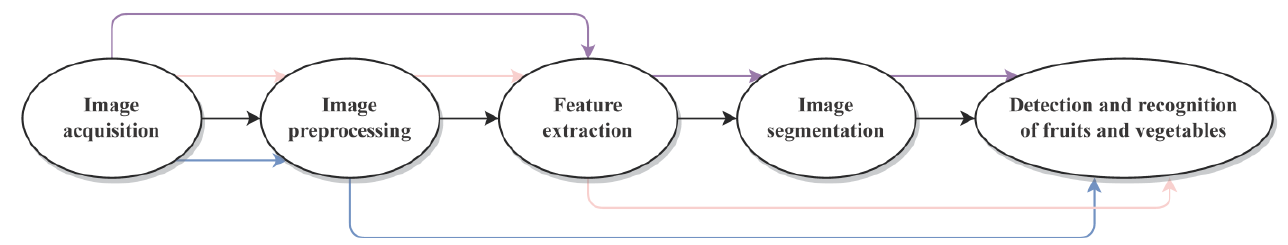
Figure 3. Different processes of object detection and recognition of fruits and vegetables.